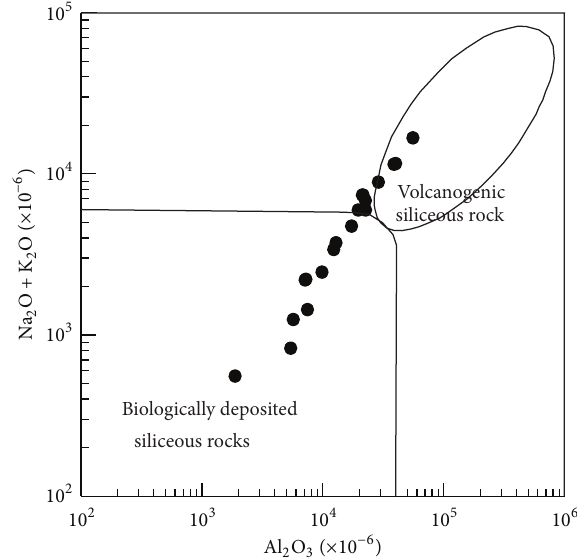
Figure 10: Fe 2 O 3 /TiO 2 versus Al 2 O 3 /(Al 2 O 3 + Fe 2 O 3 ) discrimina- tion diagram indicating the formation environment of the siliceous rocks of the Bafangshan-Erlihe area (After [53]).